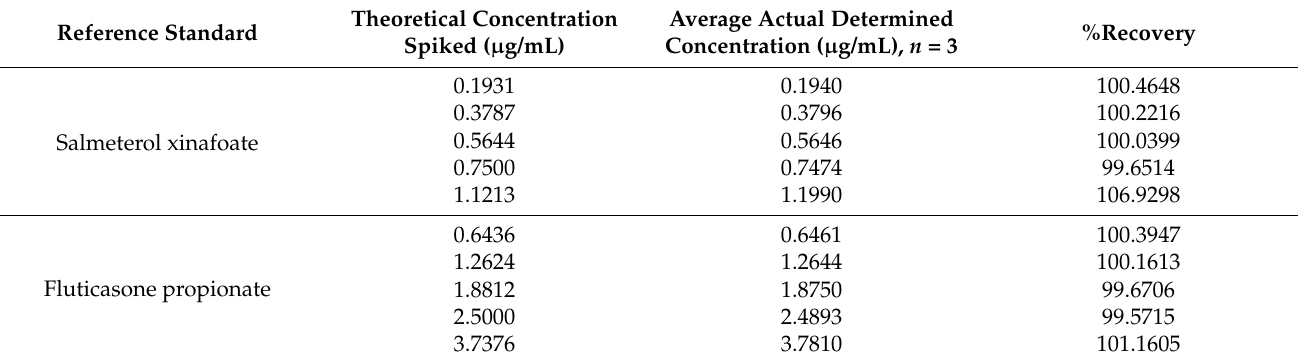
Table 3. Theoretical spiked concentration, the average actual determined concentration, and the percent recovery of salmeterol xinafoate and fluticasone propionate.